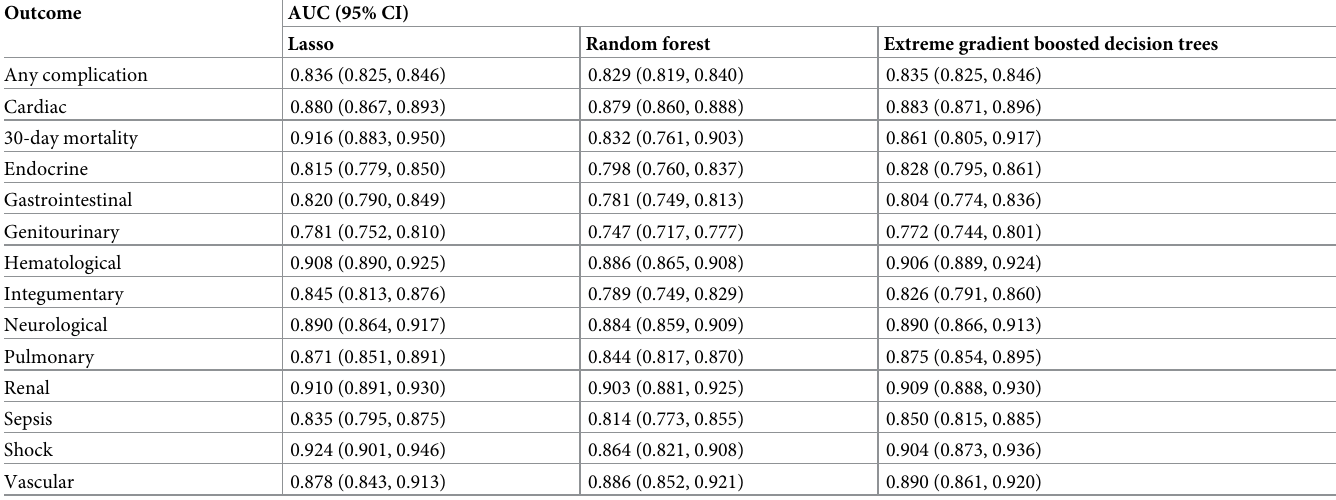
AUC, area under the receiver operator characteristic curve; lasso, least absolute shrinkage and selection